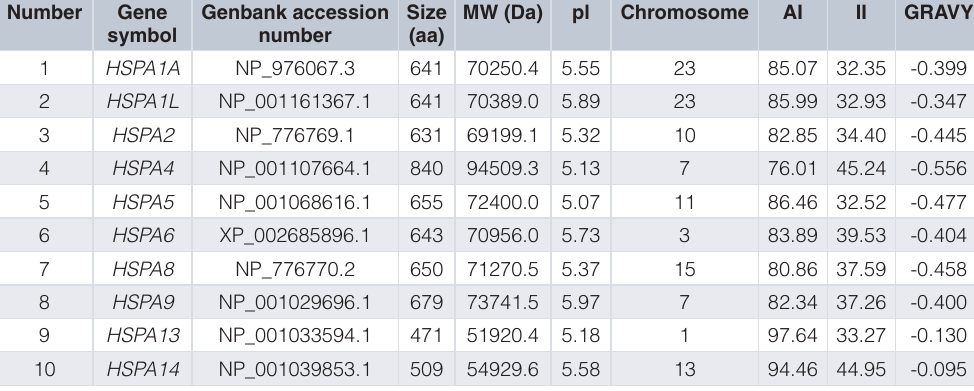
Table 3. Biochemical characterization of the bovine heat shock protein 70 protein